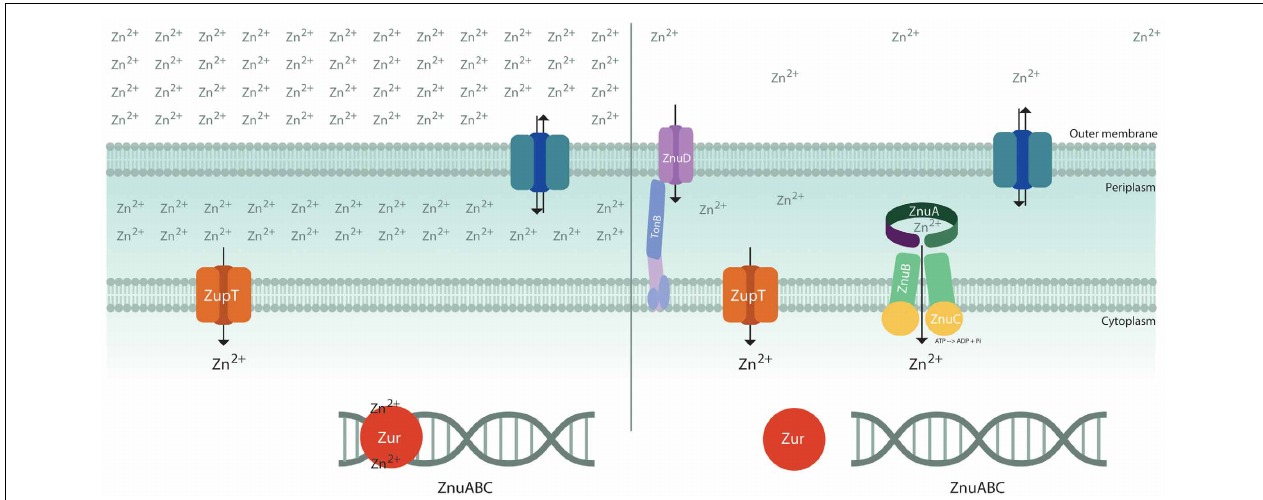
FIGURE 1 | Schematic diagram of transporters involved in zinc uptake. The bacterial outer membrane is thought to be permeable to hydrophilic solutes of < 600 dalton (Nikaido and Vaara, 1985) and, therefore, zinc concentration in the periplasmic space is largely dependent on zinc availability in the environment. Under zinc replete conditions (left), the metal is imported